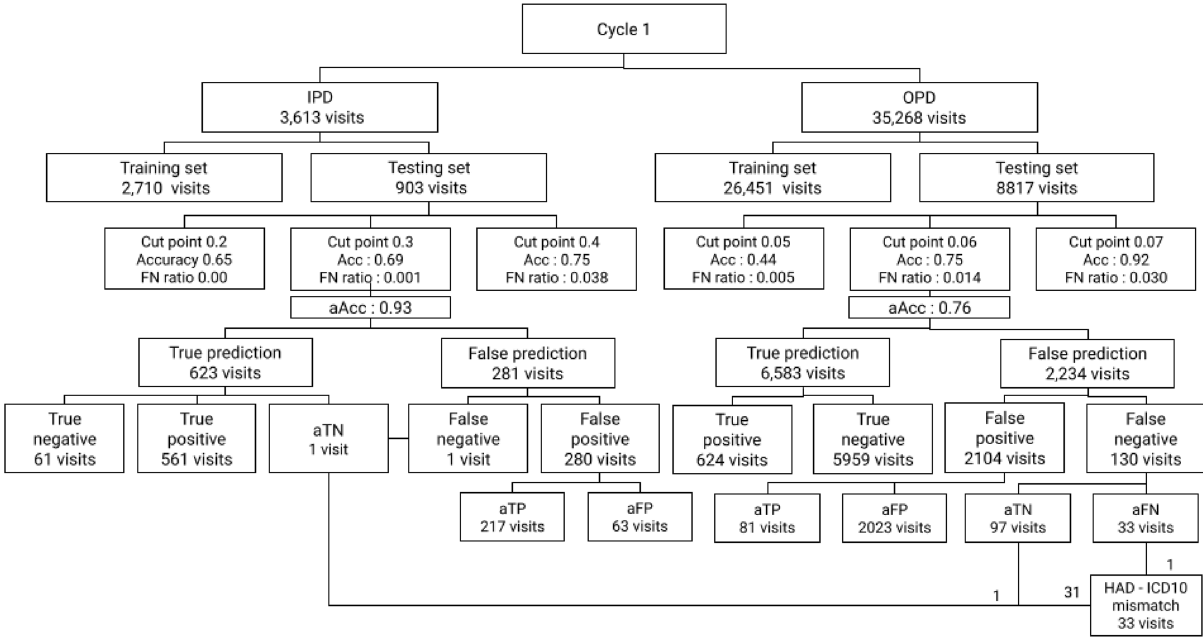
Figure 7. HAD classification result in Cycle 1.